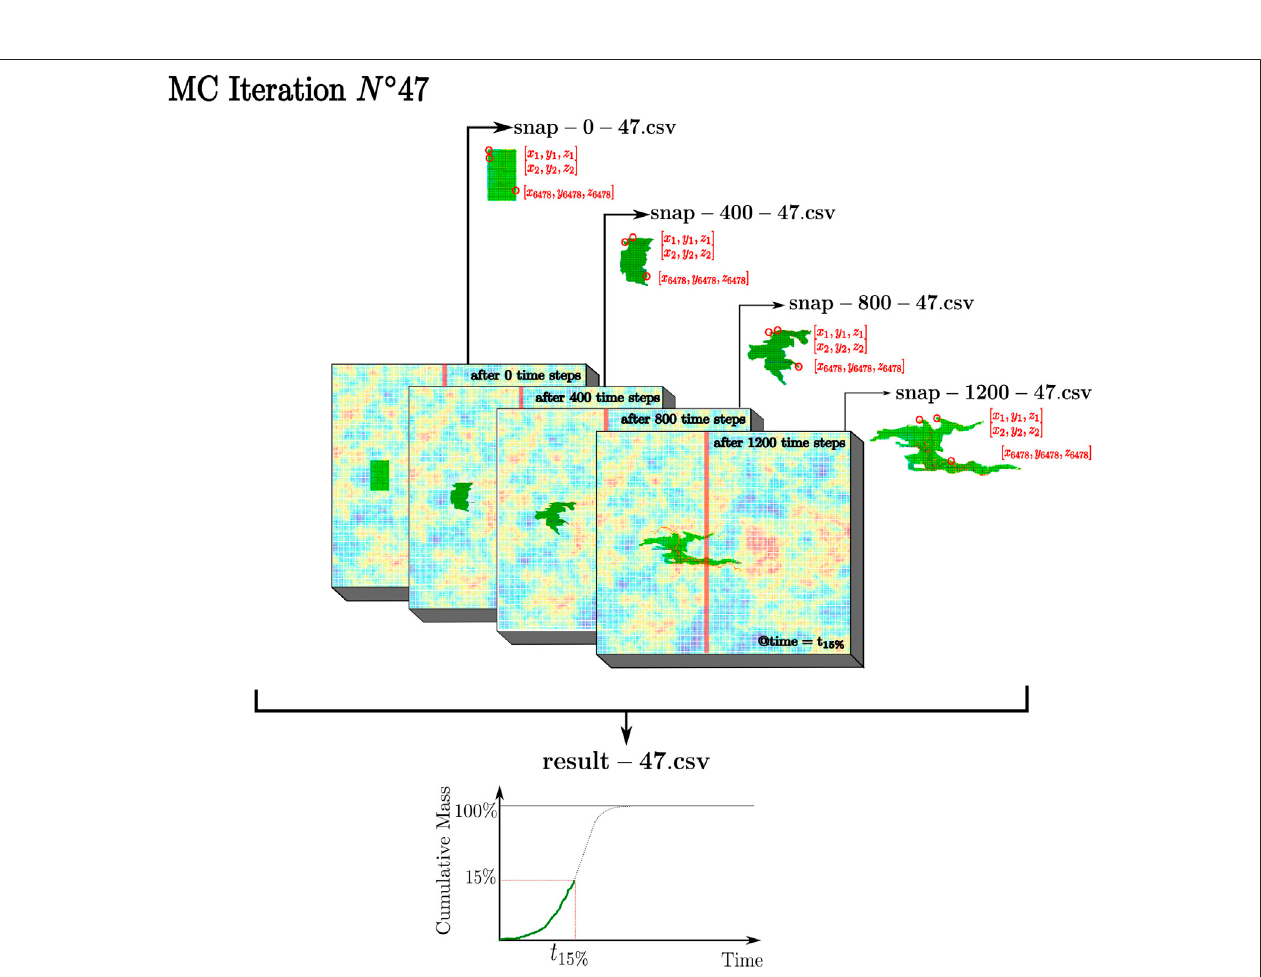
FIGURE 3 | Schematic representation of the contaminant transport simulations code cell output. The image schematizes a possible output (depending on the declared parameters in the YAML fi le) of a randomly selected hydraulic conductivity fi eld from the Monte Carlo ensemble (realization number 47). The model output for this speci fi c hydraulic conductivity realization is given by “ result-47.csv ” . This fi le contains the data related to the contaminant ’ s cumulative breakthrough curve at the control plane (represented by the vertical red line). In addition, snapshot fi les are generated for 400 simulation time steps. For example, “ snap-0-47.csv ” , “ snap- 400-47.csv ” , “ snap-800-47.csv ” and “ snap-1200-47.csv ” contain the position of each particle at time steps 0, 400, 800 and 1200. For visualization purposes, the position ( x = [ x , y , z ]) of the 1 st , 2 nd and 6478 th particles are highlighted by red circles.